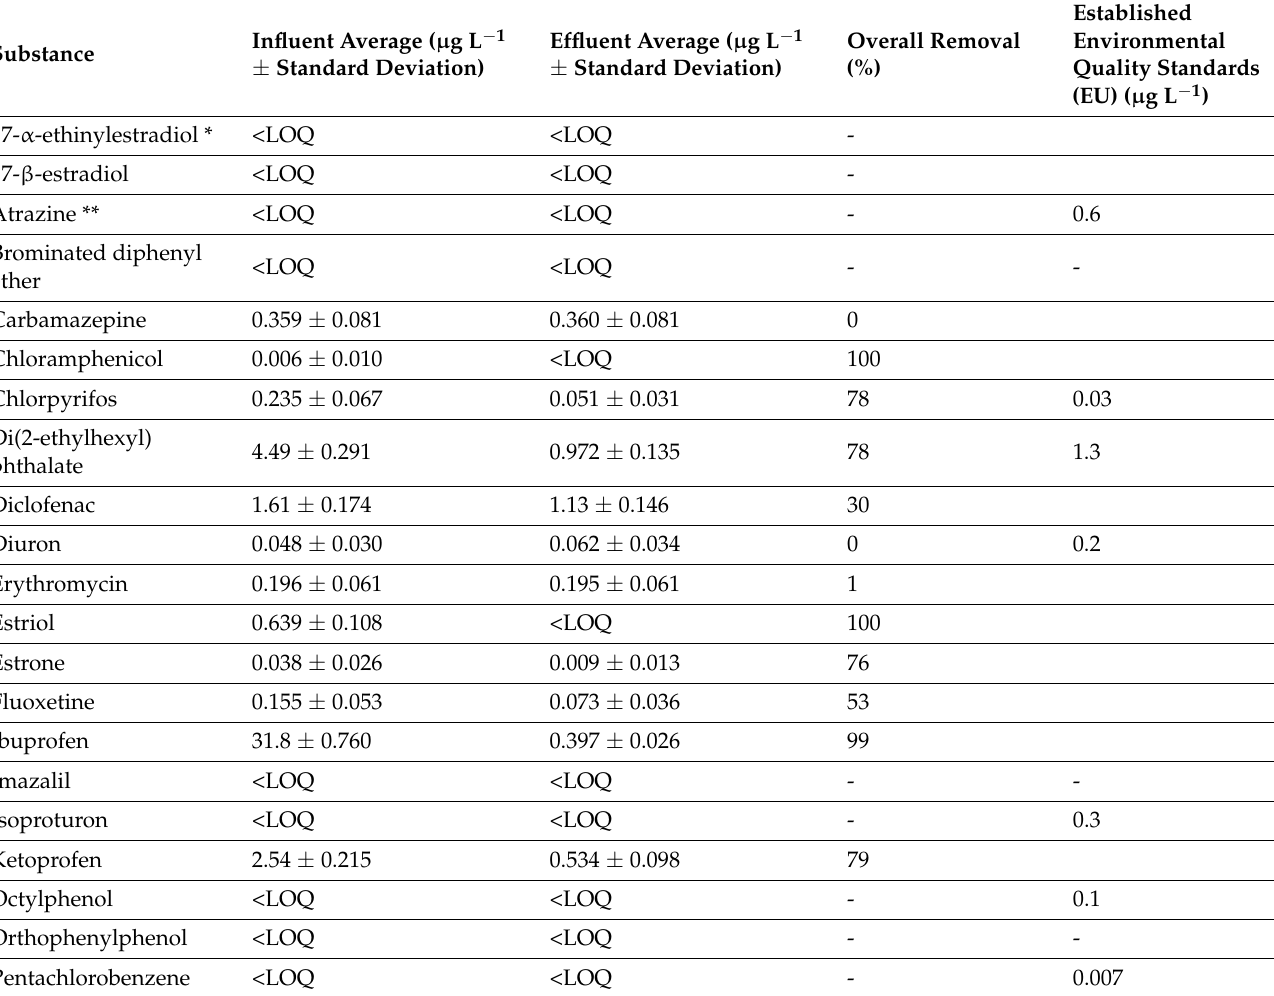
Table 3. Mean influent and effluent concentrations (annual average), mean global removal, and established environmental quality standards